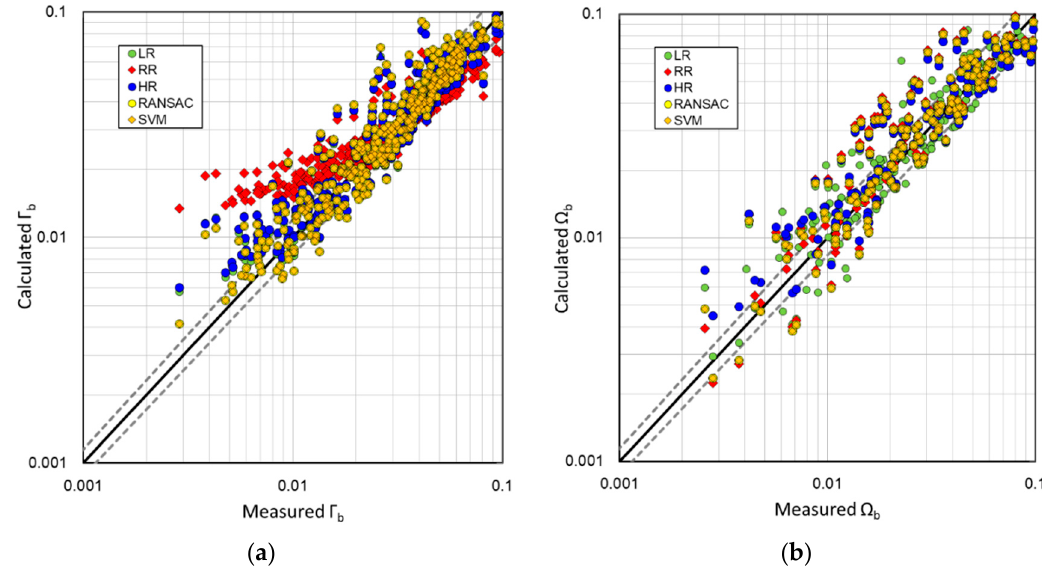
Figure 7. Comparison of the predicted wave breaking index using test data: ( a ) estimated wave breaking height; ( b ) estimated wave breaking depth.